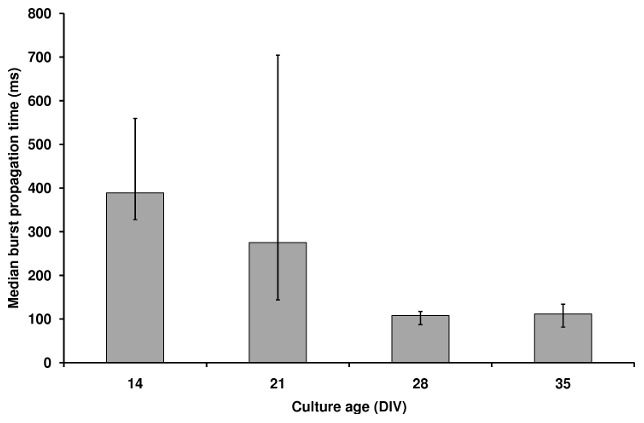
Network-wide burst propagation time as a function of culture age.Bar chart shows the median burst propagation time (from all transient networks of all cultures at each age), values outside the 5th to 95th percentiles were removed as outliers, giving n = 6–8 for each age). Error bars show 25th and 75th percentiles. A (network-wide) burst was defined as a near-simultaneous (within 250 ms) occurrence of channel bursts on multiple (≥4) channels. A channel was considered to display bursting activity if ≥4 spikes were detected in 100 ms. For each channel included in the burst, recruitment time was the timestamp of the first spike in the ≥4 spikes in 100 ms sequence. Burst propagation time was calculated as the time to recruit all channels in a network-wide burst. At DIVs 28 and 35, this time was significantly lower than at DIV 14.